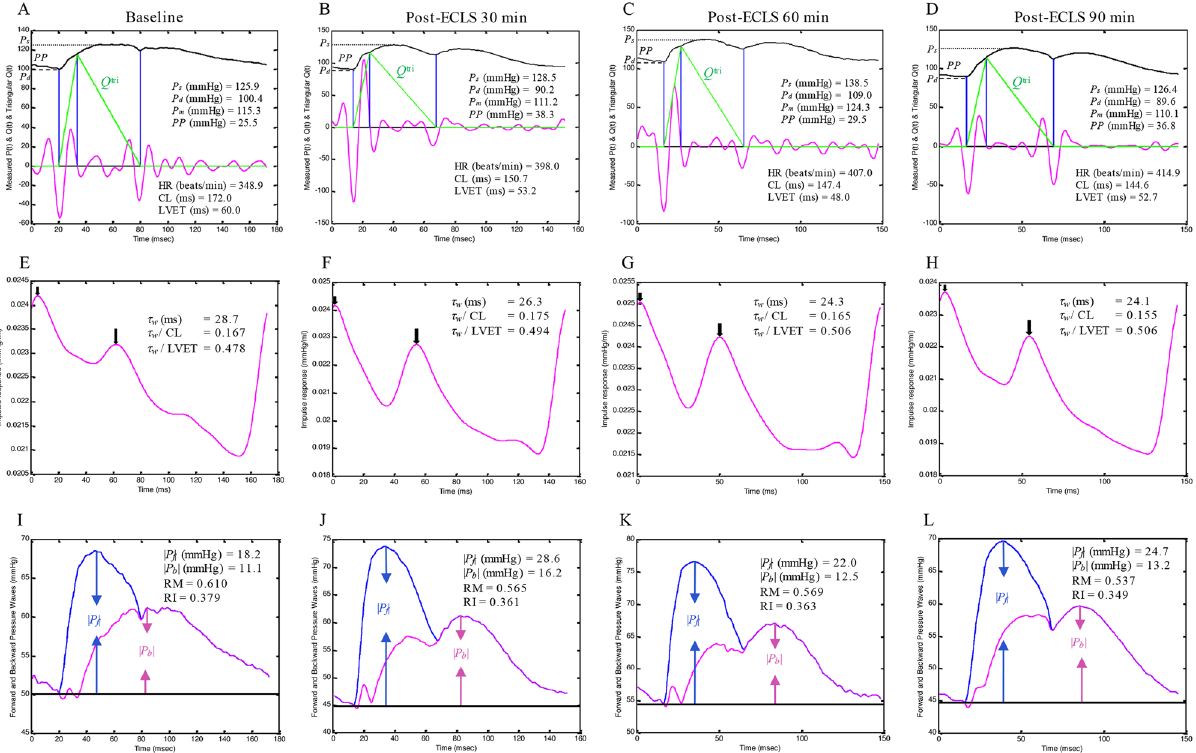
Figure 1. Construction of an uncalibrated Q tri derived from the measured pressure waveform in a rat at baseline ( A ) and at 30 ( B ), 60 ( C ), and 90 ( D ) min post-ECLS. In ( E–H ), the aortic impulse response function curve derived from the measured aortic pressure and its assumed Q tri . In ( I–L ), the amplitudes (peak – trough) of the P f and P b are described by | P f | and | P b |, respectively. CL = cardiac cycle length; HR = basal heart rate; LVET = left ventricular ejection time; P b = backward pressure wave; P d = diastolic pressure; P f = forward pressure wave; P m = mean aortic pressure; P s = systolic pressure; PP = pulse pressure; Q tri = triangular flow;